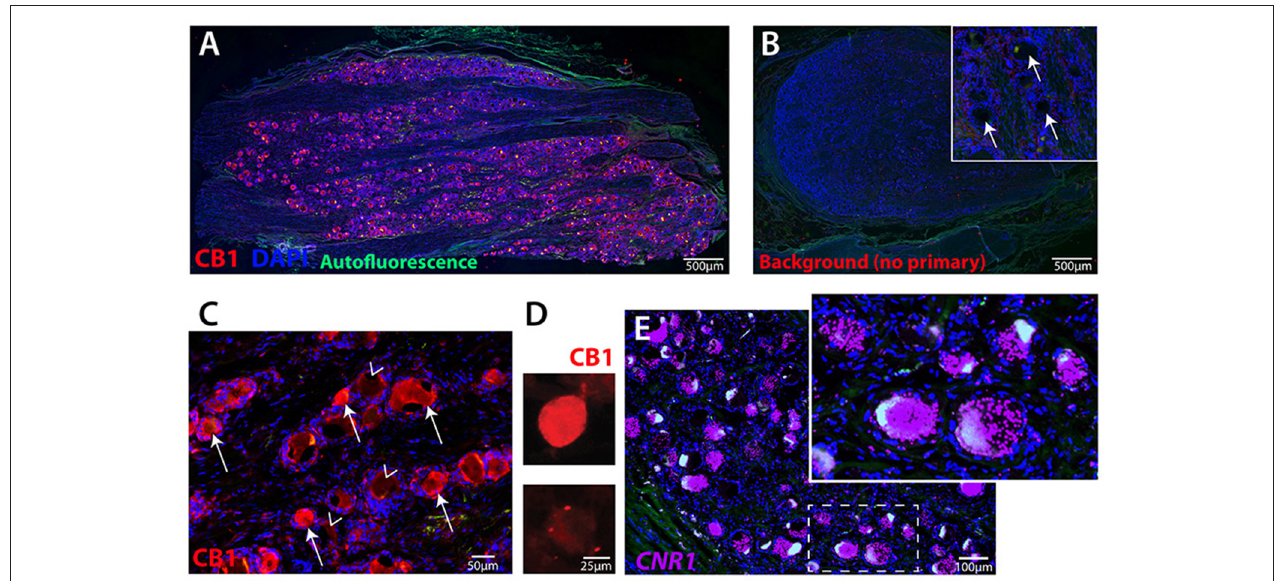
FIGURE 1 | Human primary sensory neurons robustly express CB1 receptor. (A) Image of hDRG section showing CB1 expression (red), DAPI nuclear expression (blue), autofluorescence (green). (B) hDRG section with DAPI and no primary antibody showing the nuclei of satellite cells encircling neuron soma locations (inset, arrows). (C) CB1 primary antibody and alexa-fluor 555 secondary indicates neuronal expression of CB1 receptor protein on many (arrows), but not all (arrowheads), neurons. (D) Dissociated hDRG neurons in culture retain CB1 expression detected by fluorescent secondary, and (E) Fluorescent in situ hybridization (RNAscope) for human CNR1 gene. Inset shows highly-labeled cells with densely packed